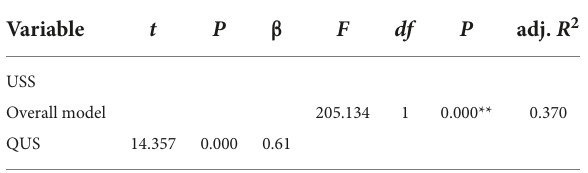
TABLE 7 Simple regression analysis by